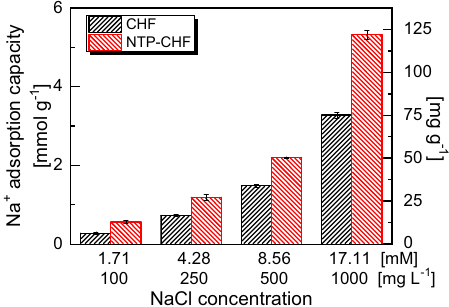
Fig. 4 Na + adsorption capacity of CHF and NTP-CHF at various NaCl concentrations. Error bars represent standard